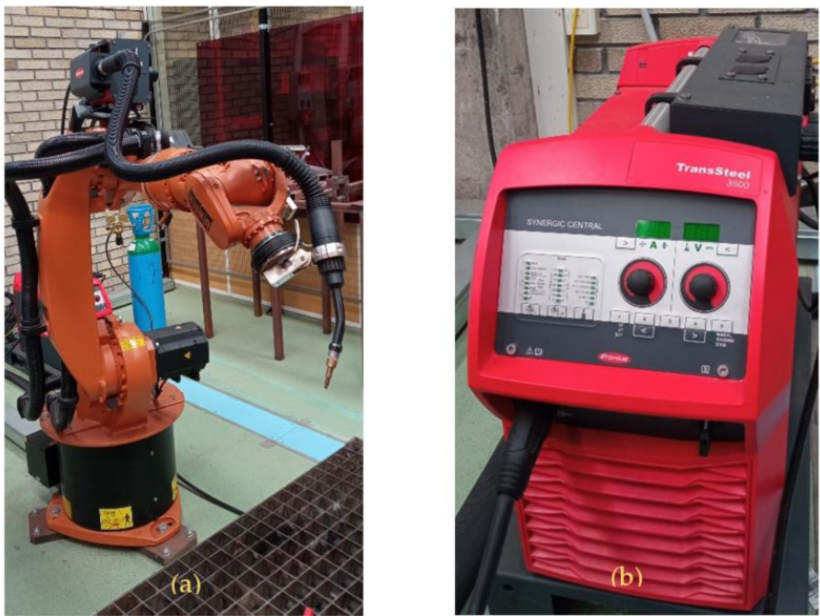
Figure 2. ( a ) Robot KUKA Kr 16, Torch and wire feed motor, ( b ) Fronius power generator Transteel